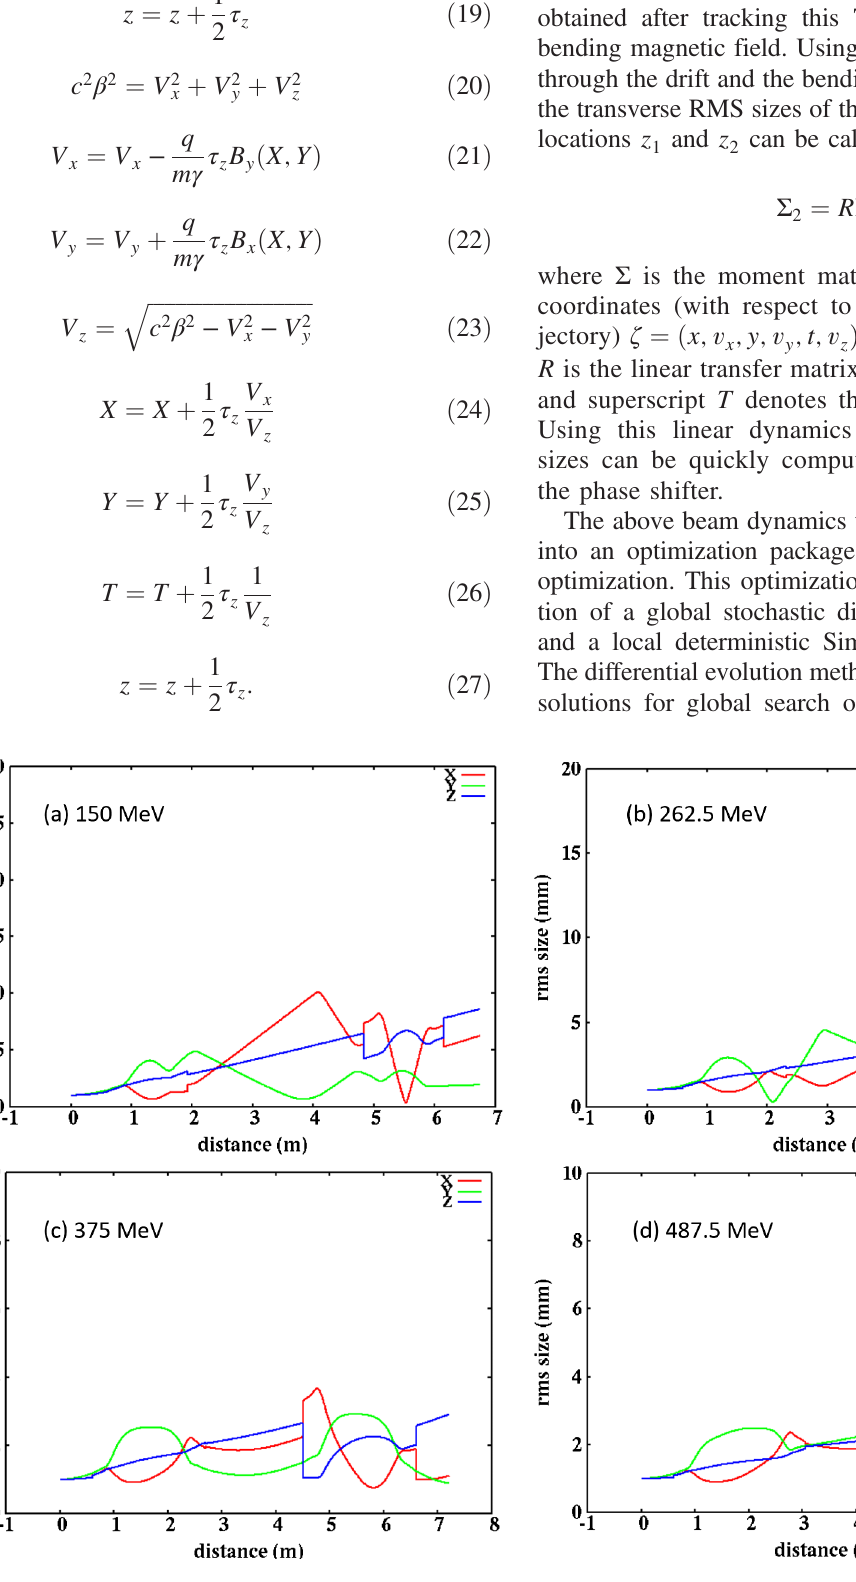
FIG. 7. Proton beam transverse and longitudinal RMS size evolution through the phase shifter with 150 MeV (top left), 262.5 MeV (top right), 375 MeV (bottom left), 487.5 MeV (bottom right) kinetic energy, initial Waterbag distribution, and 40 mA